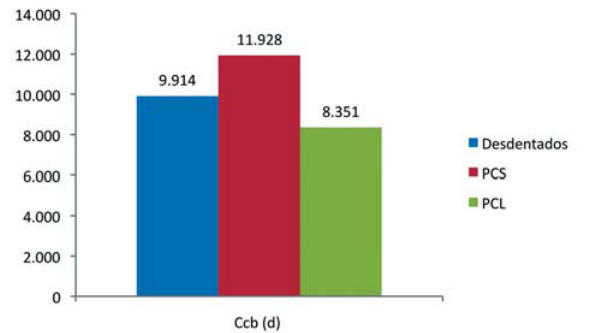
Fig. 5 - Perfil hematológico dos pacientes com doença coronariana, com e sem periodontite crônica leve e grave. Ccb = Contagem de células brancas; PCS = Periodontite crônica grave; PCL = Periodontite crônica leve; A Ccb foi convertida em uma escala logarítmica para a comparação de médias